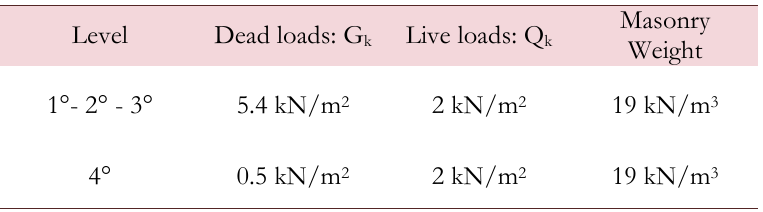
Table 3: Values of loads and masonry